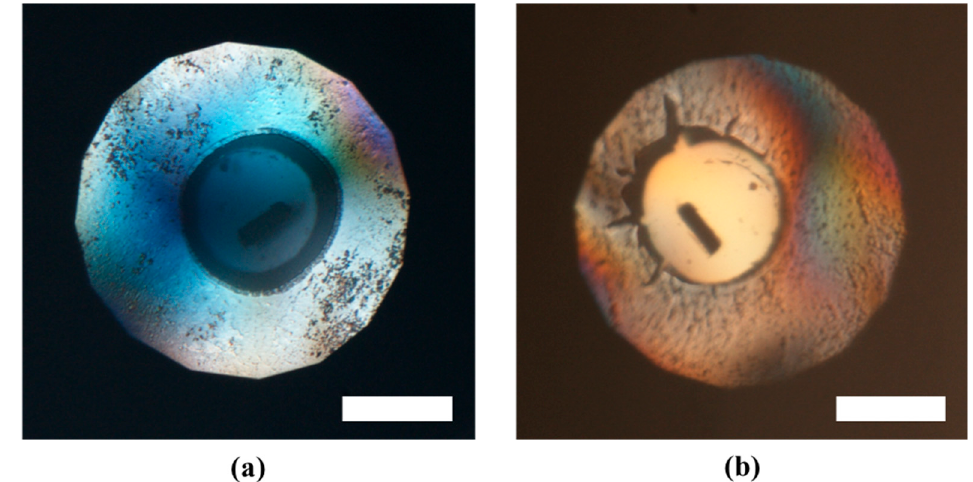
Figure A3. Optical microscope images of the sample studied by high pressure single crystal diffraction ( a ) prior to measurement at 9.6 GPa, front view, and ( b ) post measurement at 11.2 GPa, reverse view (scale bar = 200 μ m).